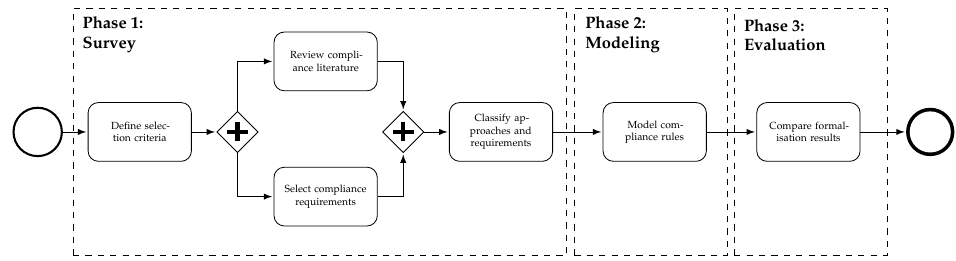
Figure 1. Phases of applied research